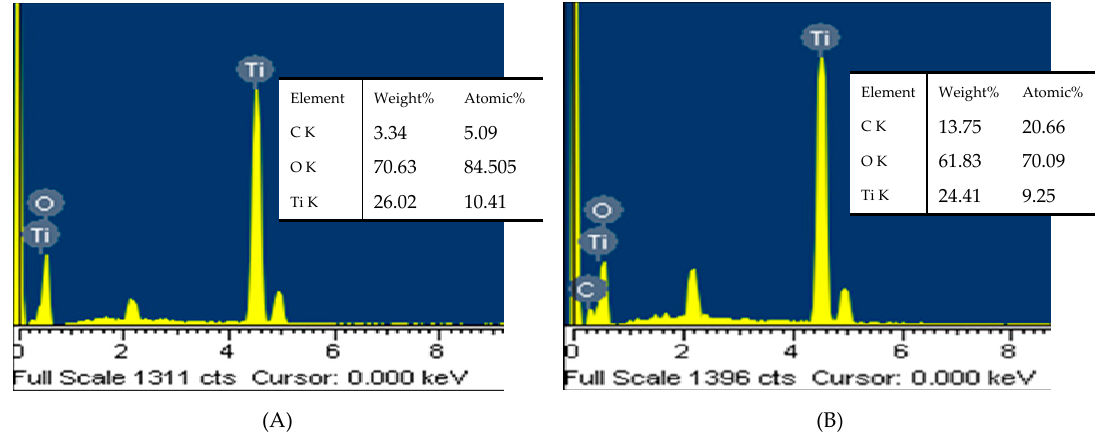
Figure 6. Energy dispersive x-ray spectroscopy (EDX) analysis of ( A ) material (MT1) and ( B ) MT2.